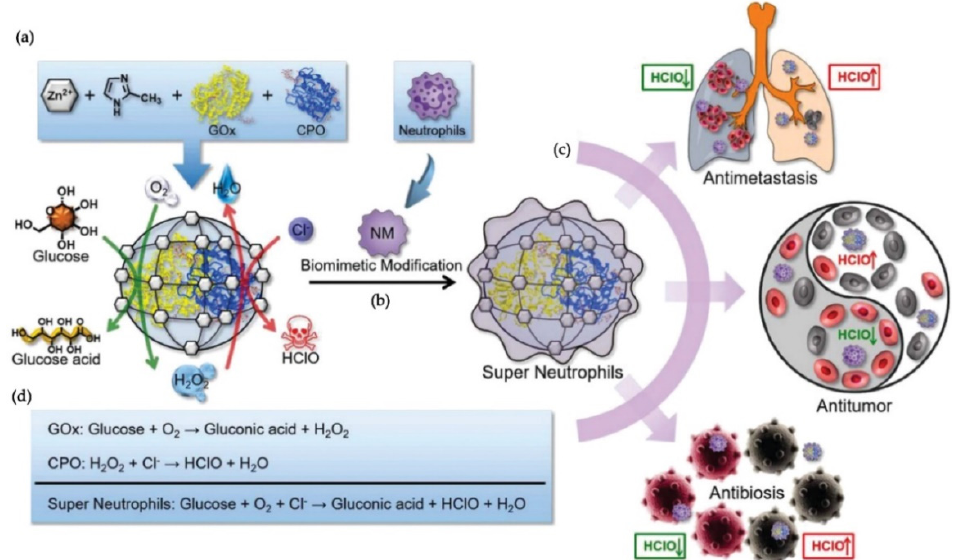
Figure 7. Schematic illustration of the biomimetic fabrication, biological reaction process, proposed mechanism and diverse biomedical applications of the “super neutrophils.”( a ) The synthesis of two enzymes-embedded ZIF-8 nanoparticles by Zn 2+ , 2-methylimidazole, glucose oxidase (GOx), and chloroperoxidase (CPO); ( b ) the biomimetic fabrication of the “super neutrophils” by the surface modification of the GOx/CPO-embedded ZIF-8 nanoparticles with the natural neutrophil membrane (NM); ( c ) stronger HClO generation ability and fewer systemic side effects of the “super neutrophils” than the intrinsic neutrophils for promising antimetastatic, antitumor and antibiosis applications; ( d ) the enzymatic reaction of GOx, CPO and the “super neutrophils”. Reprinted with permission from Ref. [27]. Copyright 2019 John Willey and Sons.